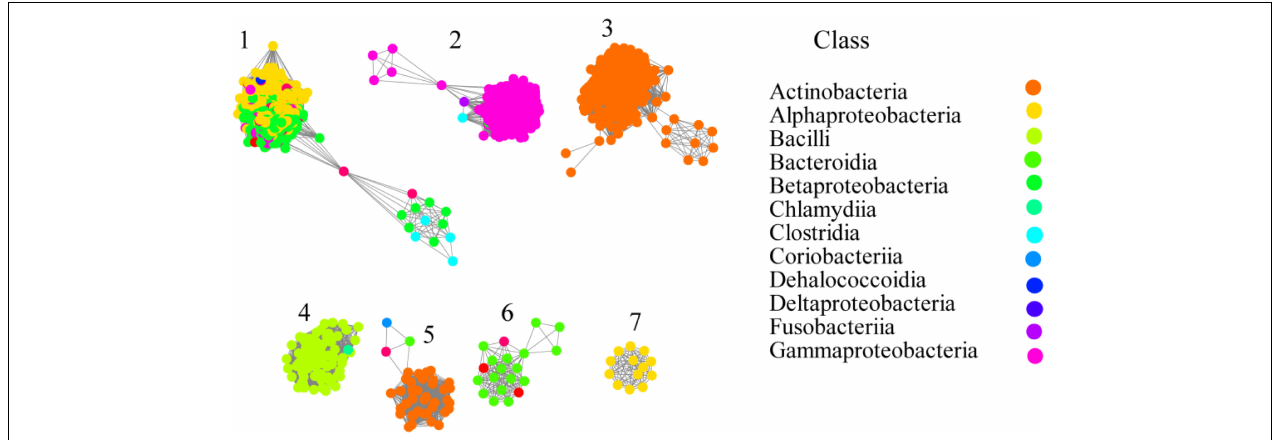
FIGURE 1 | Networkanalysis of oxalyl-coenzyme A decarboxylase (OXC) based on sequence similarity. Each node represents one protein. The protein sequences are listed in the Supplementary Sheet . Edges are shown with BLASTP e-values below 10 − 180 . A cluster was sequentially labeled. Nodes from the same taxonomic groups (Class level) in the network have been painted the same color. The colors corresponding to each class are listed at the right section. The experimentally characterized OXC from Oxalobacter formigenes (Uniprot ID: P40149; Cluster 1), Escherichia coli (Uniprot ID: P0AFI0 or P0AFI1; Cluster 2), Lactobacillus acidophilus (Uniprot ID: A0A378H7I7; Cluster 4) Bifidobacterium animalis (Uniprot ID: B8DWU2; Cluster 5) are enlarged and circled.